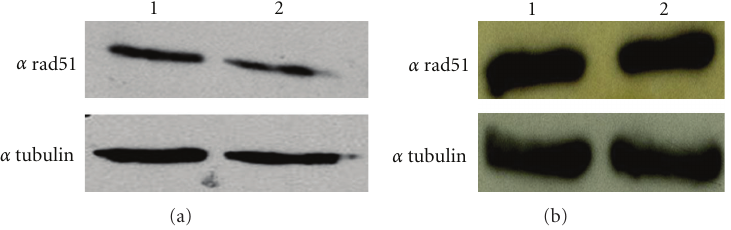
Figure 3: The over-expression of the β 2 subunit of proteasome did not alter the level of Rad51p. We determined the level of Rad51p after treatment with 30 μ M MG132. (a) 30 μ g of total protein extract was loaded as follows: line1: negative control. line 2: extract by cells treated with MG132. We also determined the e ff ect of the β 2 subunit over-expression on Rad51p level. (b) 30 μ g of total protein extract was loaded as follows: lane 1: total protein extract by control cells; lane 2: extract by cells overexpressing the proteasome subunit. α tubulin was detected as loading